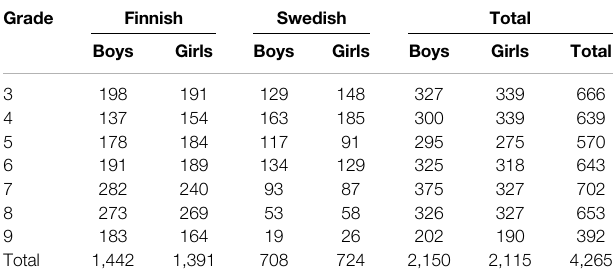
TABLE 1 | The sample sizes in different cells of grade, gender, and